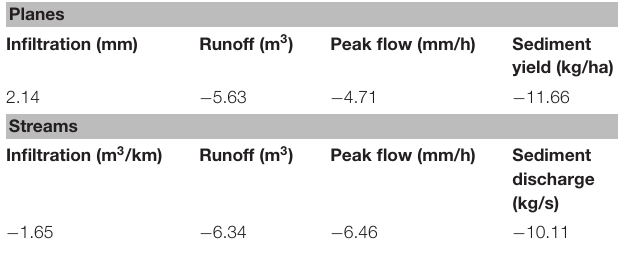
TABLE 3 | Summary of KINEROS2 average percent change outputs results from the two scenarios (before UGI intervention and after UGI intervention) in terms of total watershed changes: average percent runoff (m 3 ); peak flow (mm/h); and sediment yield (kg/ha) and infiltration (m 3 /km) for planes that intersect with a proposed UGI placement and all streams (all streams are within 2 miles of a